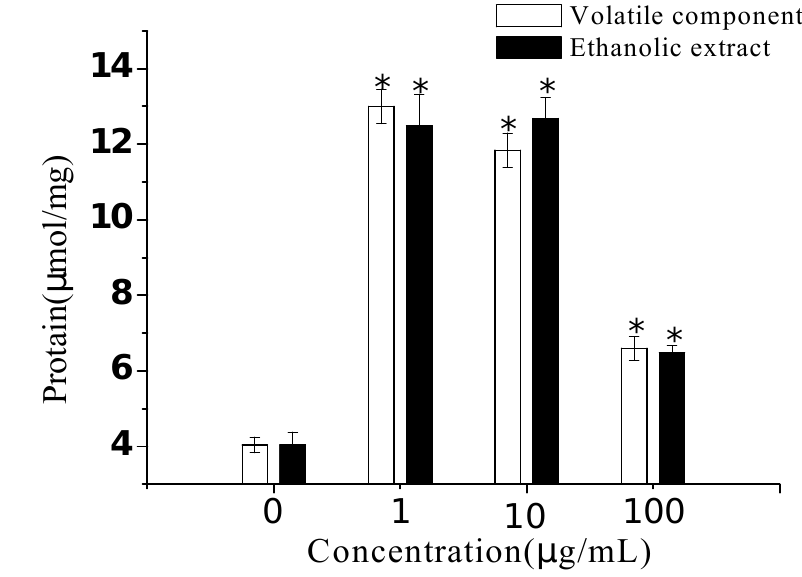
Figure 2. Effects of volatile components and ethanolic extract from E. prostrata on the ALP activity of primary osteoblasts (n = 8, x ± SD; * p < 0.01, compared with